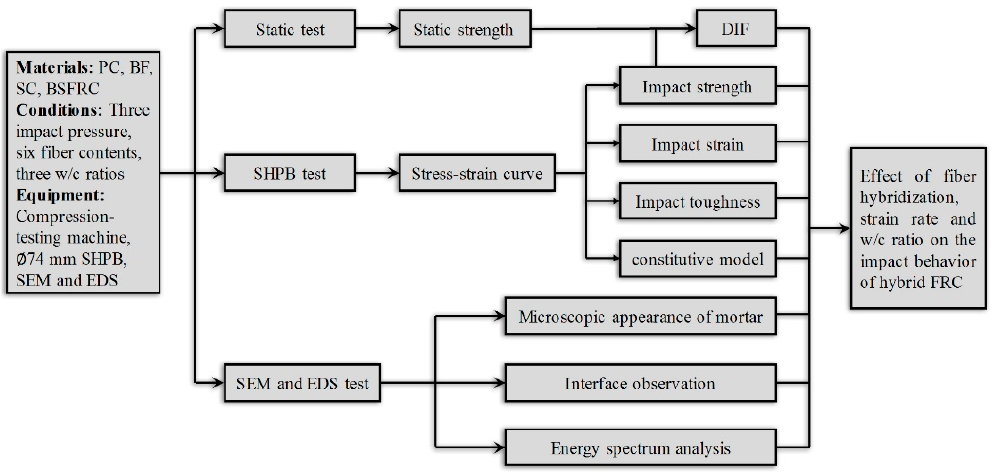
Figure 1. The methodological framework flow chart.